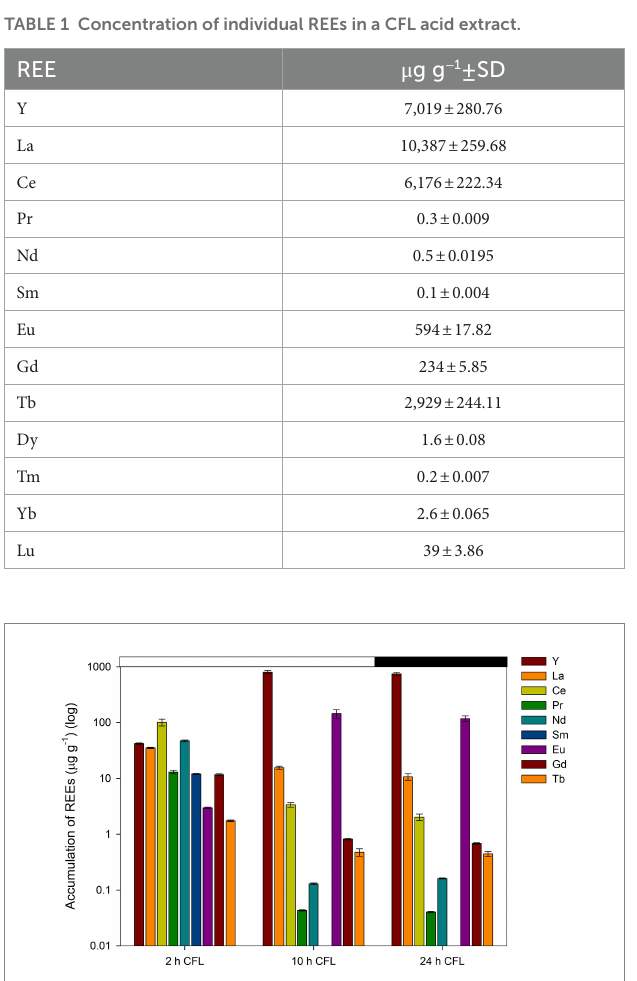
FIGURE 6 Accumulation of individual REEs in synchronous cultures of Galdieria sulphuraria under CFL–treatment expressed as concentration in μ g g − 1 . The Y axis has a logarithmic scale. The X axis represents three different phases of the cell cycle (growth phase, commitment point, end of the cell cycle). The dark phase is indicated by the black bar above the graph. The error bars represent standard deviations (±SD). For details of statistical analysis (one-way ANOVA, Tukey’s HSD) see Supplementary Table S2.